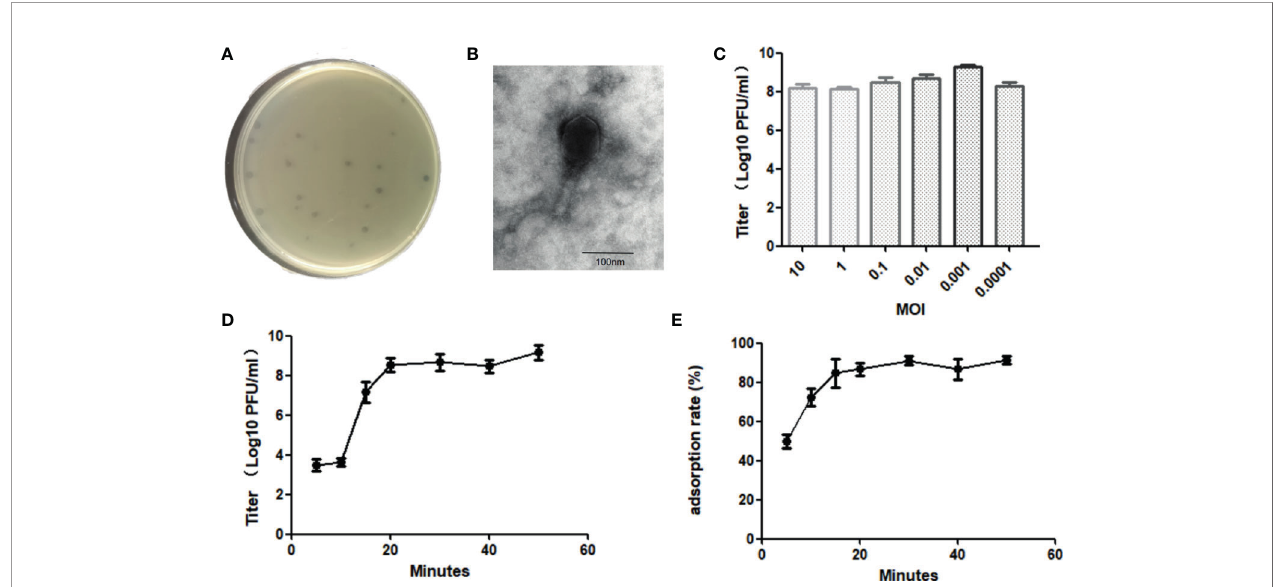
FIGURE 1 | Biological characterization of E. faecalis phage vB_EfaM_LG1. The plaque (A) and transmission electron micrograph (B) of LG1. (C) The optimal MOI test of phage. (D) The one-step growth curve of LG1. (E) The adsorption rate of LG1 against host strain ef118 within 60